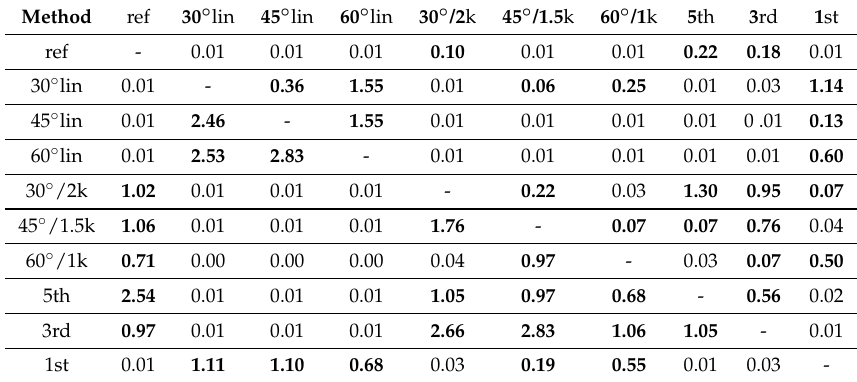
Table 3. p -values (Wilcoxon signed-rank test with Bonferroni–Holm correction) for ratings of timbre and spatial mapping of Experiment II. The upper triangle corresponds to timbre, the lower triangle to spatial mapping. Insignificant differences ( p -values ≥ 0.05) are indicated by bold numbers.